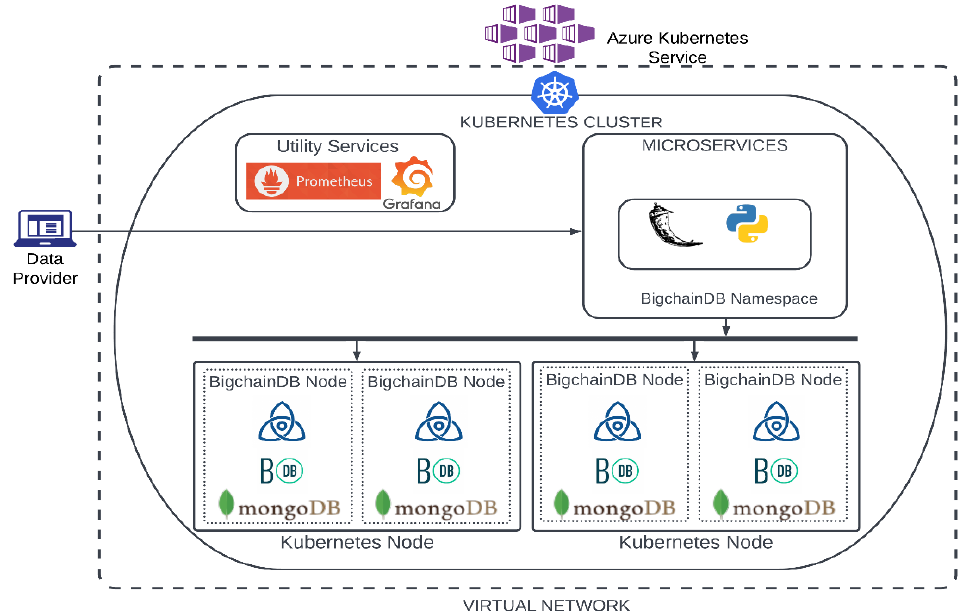
Figure 4. High-level architecture of the prototype interacting with BigchainDB.